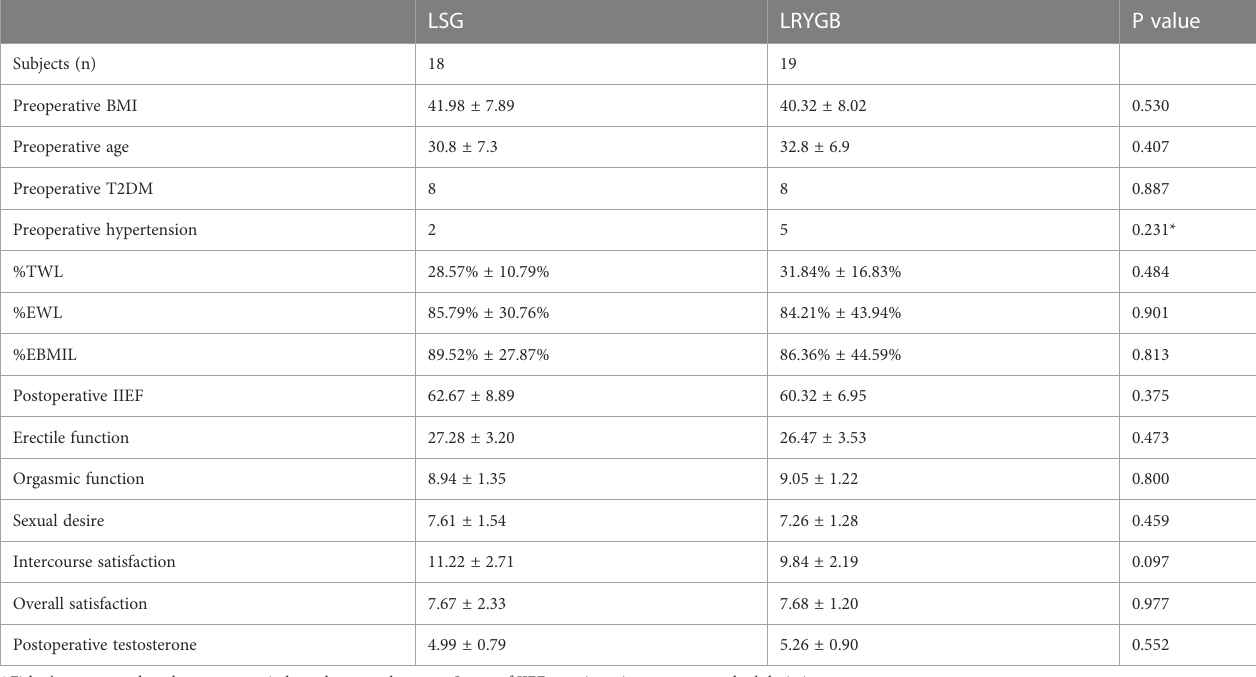
TABLE 6 Outcomes of bariatric surgery and IIEF scores of the two groups after bariatric